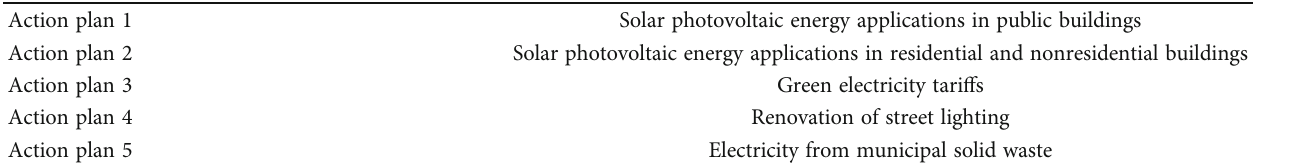
Figure 6: Global solar irradiation of Turkey [30]. Table 4: Renewable energy sector action plans for Sakarya